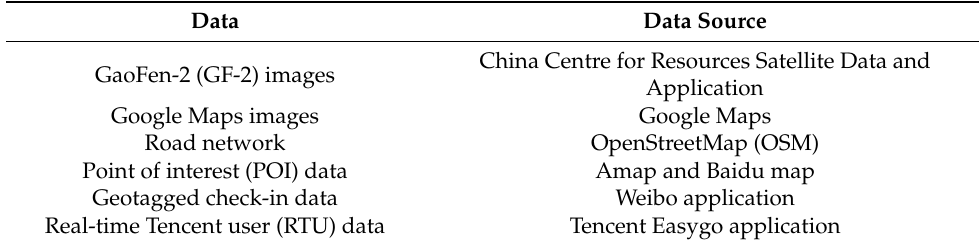
Table 1. Data and sources involved in this